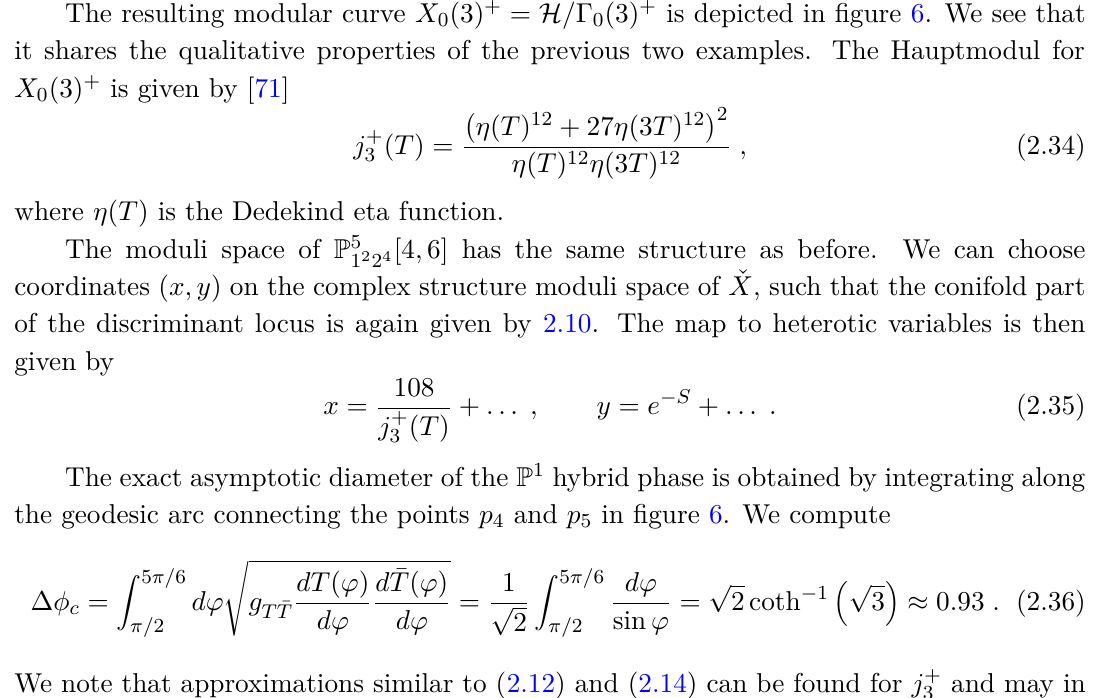
Figure 6 . Left: a fundamental domain X 0 (3) for Γ 0 (3) that is symmetric under the Fricke involu- tion F . Right: a fundamental domain for Γ 3 √ the following: p = e iπ/ 6 / 3 is an orbifold point of order 6 and p 6 point of F and c = 0 is the second cusp of X 3 0